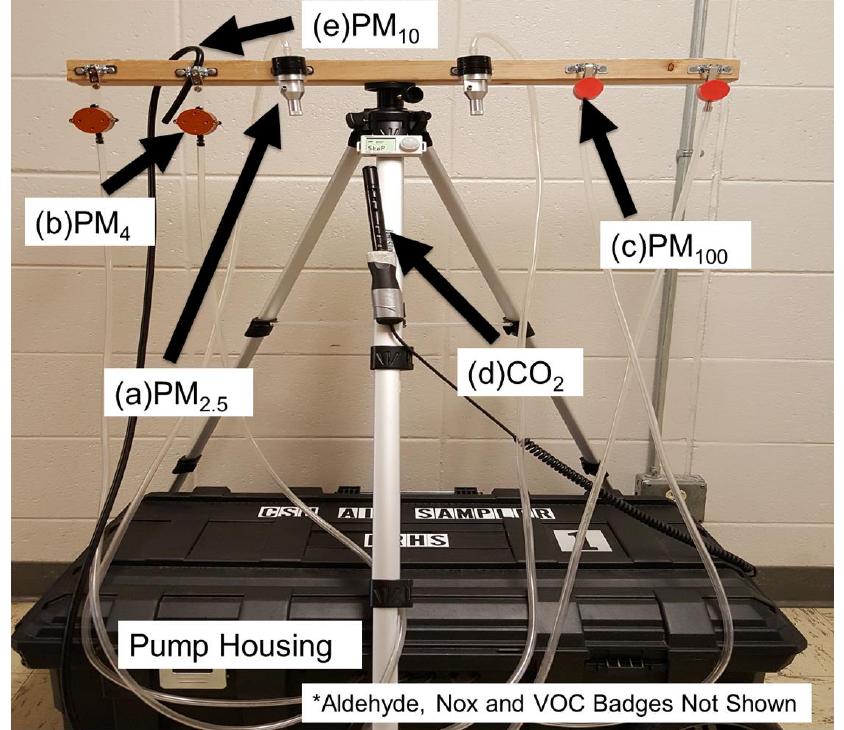
Figure 1. Customized air sampling station deployed in multiple test locations to characterize indoor air quality in di ff erent building types on a college campus. The design of this station allowed for easy integration of ( a ) two GK2.05 (KTL) aluminum cyclones for collecting PM 2.5 ; ( b ) two aluminum parallel particle impactors for collecting PM 4 ; ( c ) two SKC Button samplers for collecting PM 100 ; and ( d ) one TSI Q-trak for monitoring CO 2 in real-time. Passive badges (not shown) for measuring NO x , aldehydes, and VOCs were a ffi xed to the horizontal bar during sample collection. SKC sampling pumps were housed inside the station (black box), which contained a fan for climate